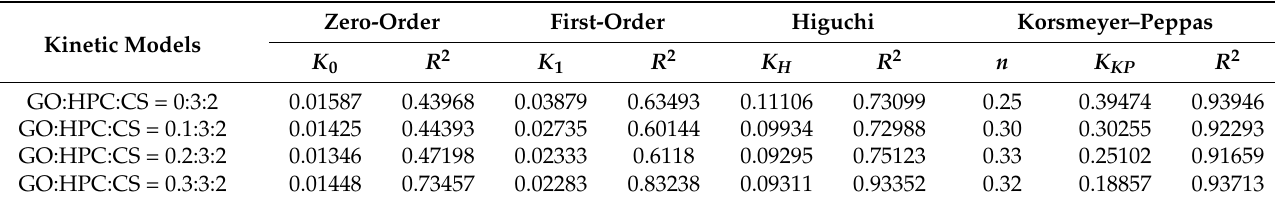
Figure 8. The linear fitted plots of the 5-Fu release from different aerogels with ( a ) zero-order, ( b ) first-order, ( c ) Higuchi, and ( d ) Korsmeyer–Peppas models at pH = 7.4. Table 1. Kinetic parameters of four models for 5-Fu release at pH = 7.4.